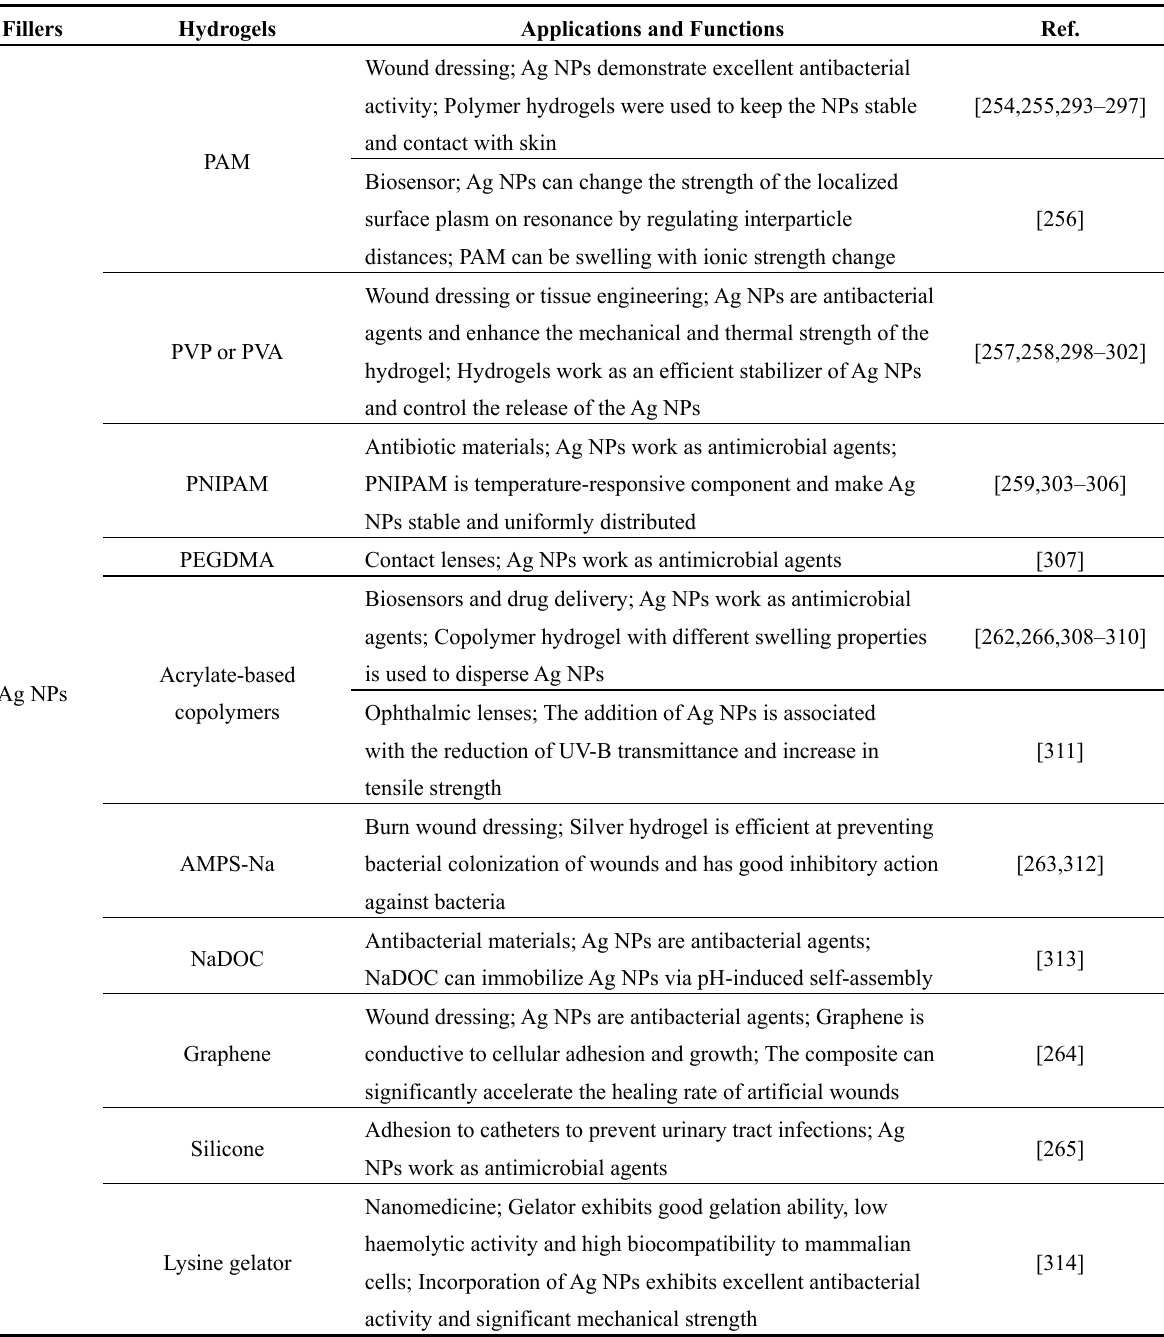
Table 3. Summary of nanocomposite hydrogels from hydrogels and metal or metal oxide NPs for biomedical